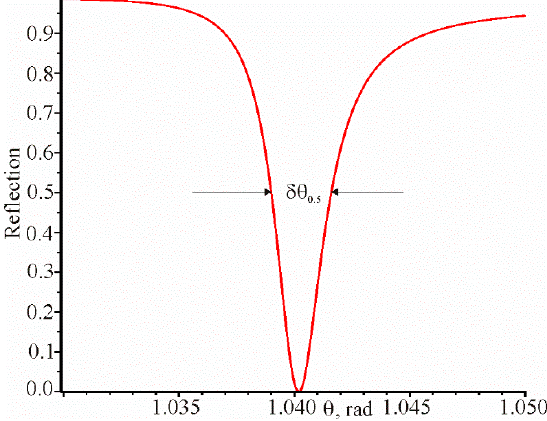
Figure 6. Angular dependence of the reflection coefficient with the following parameters: θ rez = 1.04018937, λ rez = 1.0645076 µ m , d = 52.7 nm, n = 1.56, n a = 1.3242. In this case, δ 0.002609 rad .